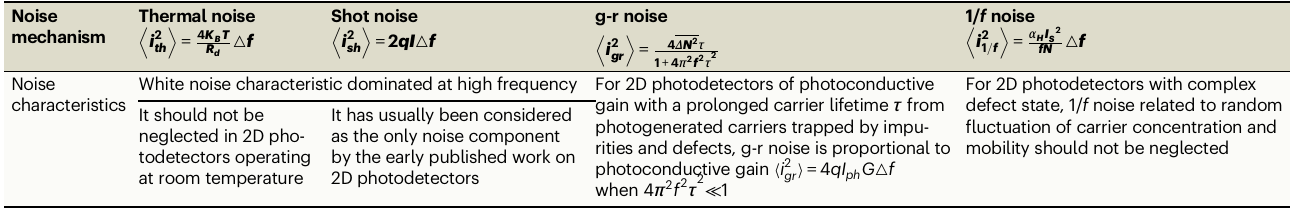
Table 2 | Dominant noise mechanisms of 2D photodetectors Noise Thermal mechanism